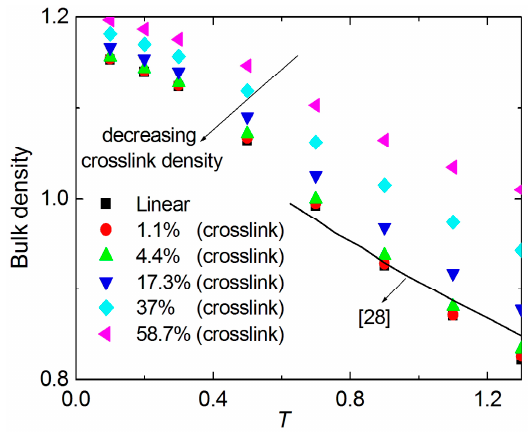
Figure 2. The distribution of the bulk density with various temperatures for different crosslink densities.